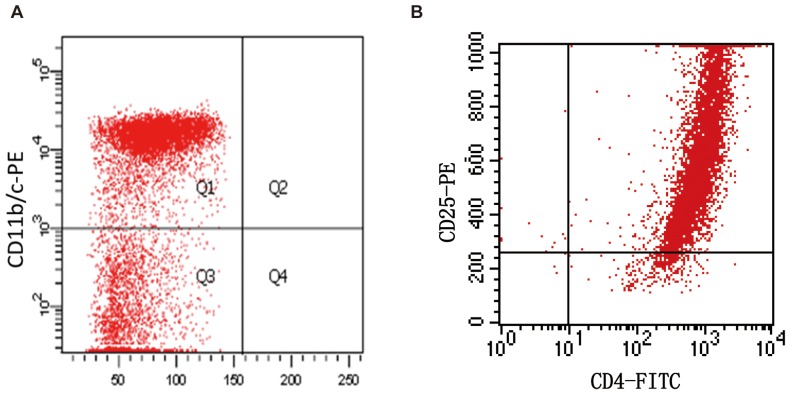
Identification of regulatory T cells and liver macrophages using flow cytometry.
A: liver macrophages were identified as CD11b/c positive cells after primary culture for 24 hours. B: The purity of Treg cells was examined after isolation using magnetic beads.